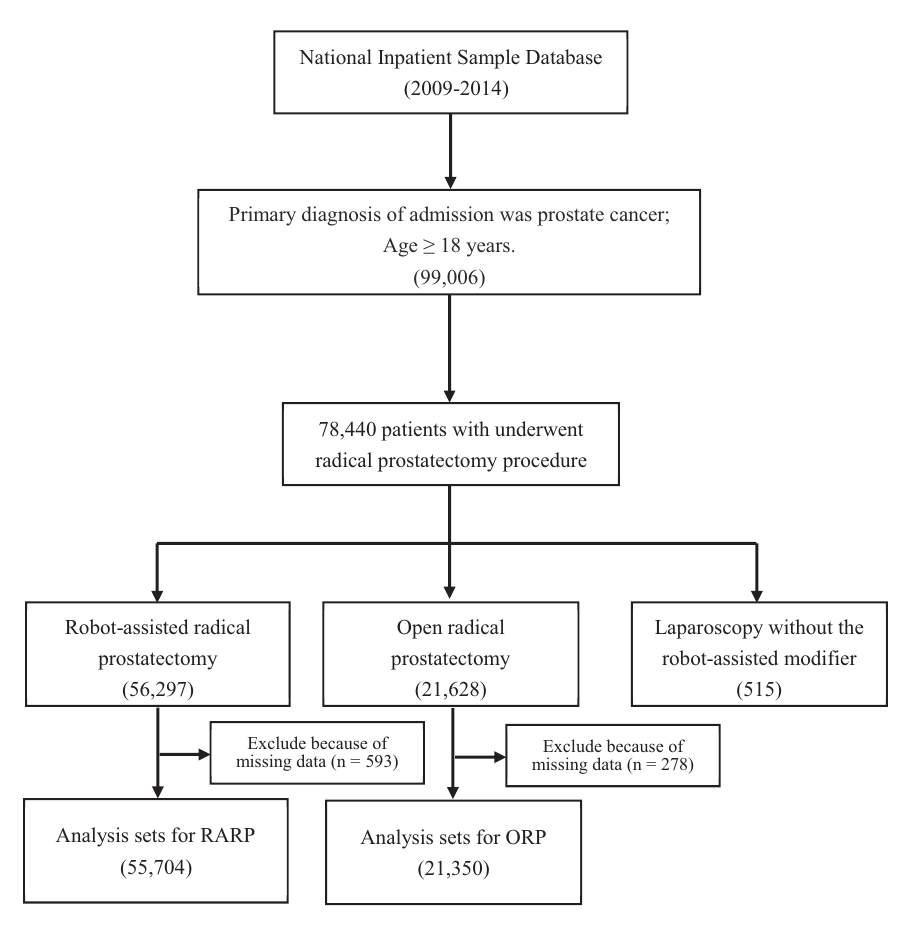
Figure 1 - The flow chart of patients